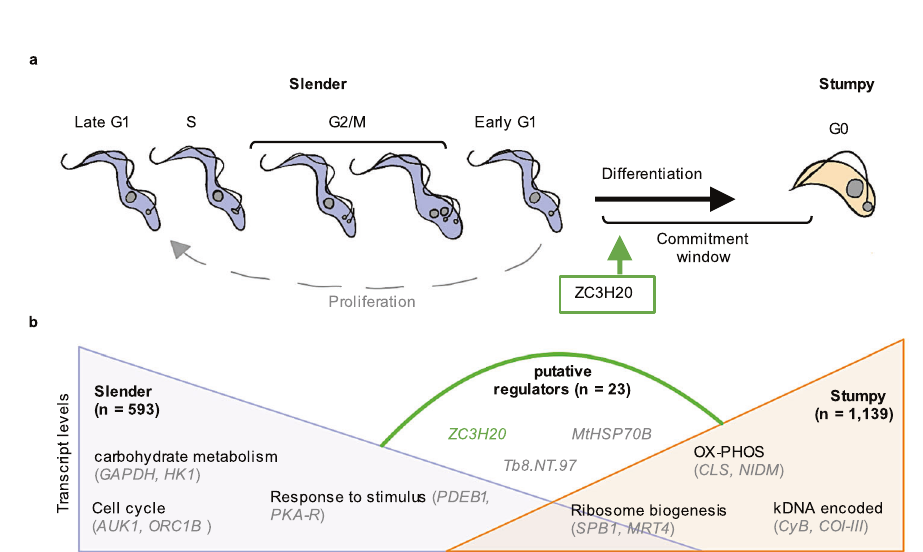
Fig. 6 Comparison of differentially expressed genes during differentiation of WT cells and differentiation incompetent ZC3H20 KO cells. a PHATE map of WT (red) and ZC3H20 KO (blue) parasites. The black lines indicates branched trajectories. Yellow dots indicate points of analysis for early differentially expressed genes. b PHATE map of ZC3H20 cells only, coloured by pseudotime values assigned for the second lineage of the branch trajectory, black line. c Scatter plot of differentiation-associated genes also found to be differentially expressed in the ZC3H20 KO trajectory. Axes show the association score (log10(wald stat)) for each gene with the WT differentiation trajectory ( x -axis) and ZC3H20 KO trajectory ( y -axis). Each gene is coloured by is co- expression module identi fi ed in Fig. 2d. Black line indicates x = y . d Heatmap of the 1791 differentiation-associated genes identi fi ed in Fig. 2d. Relative expression levels (log2 normalised z-score) across the ZC3H20 KO trajectory is plotted for each gene, grouped by co-expression module. e Expression of example genes across the WT differentiation trajectory (red) and ZC3H20 KO trajectory (blue). X -axis; pseudotime, y -axis; log2(expression + 1). f Scatter plot of genes identi fi ed as early differentially expressed across the branched trajectory (between yellow points in a ). Genes were identi fi ed by earlyDETest ( p -value < 0.05 and FC > 2). Axes show the association score (log10(wald stat)) for each gene with the WT differentiation trajectory ( x -axis) and ZC3H20 KO trajectory ( y -axis). Genes are coloured by their signi fi cant association with the WT (red), ZC3H20 KO (blue), or both trajectories (black). g Expression patterns of examples of early differentially expressed genes as in ( e ).